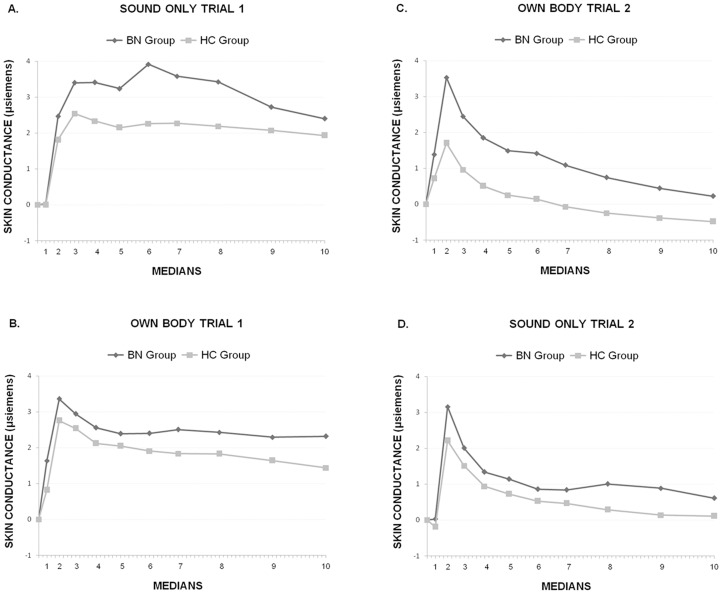
The skin conductance response to the startle-defense noise in the Bulimia (BN) and Control (CN) groups during the Sound Only trial (A) and the Own Body trial (B) presented first, and the Own Body trial (C) and the Sound Only trial (D) presented second.In general, the BN group showed a larger response to both trial types, irrespective of the presentation order. Also, when both trials were presented second (C and D), the amplitude of the response decreased significantly after Median 2 in the BN and HC groups, suggesting a habituation effect. However, at the start of this second presentation (Median 1), the response was larger for the Own Body trial than for the Sound Only trial, and for the BN group compared to the HC group, indicating less habituation.